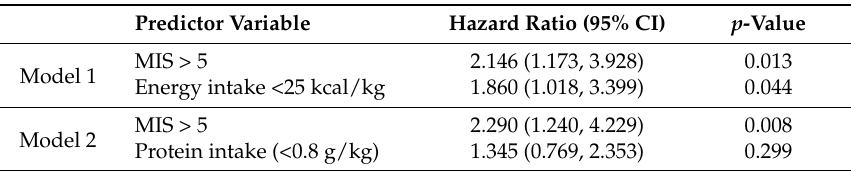
Table 6. Multivariable Cox proportional hazards analysis of all-cause mortality in end-stage renal disease patients on maintenance hemodialysis.